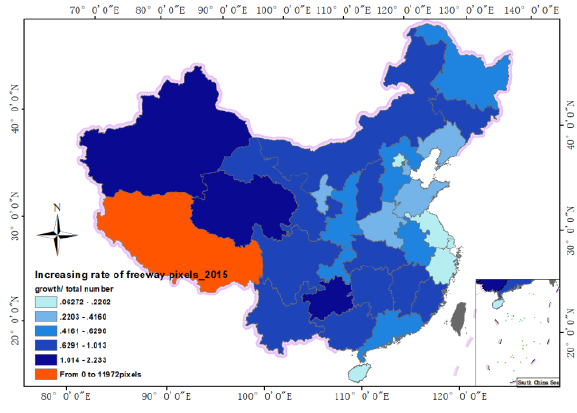
Figure 15. Changes in number freeway pixels.